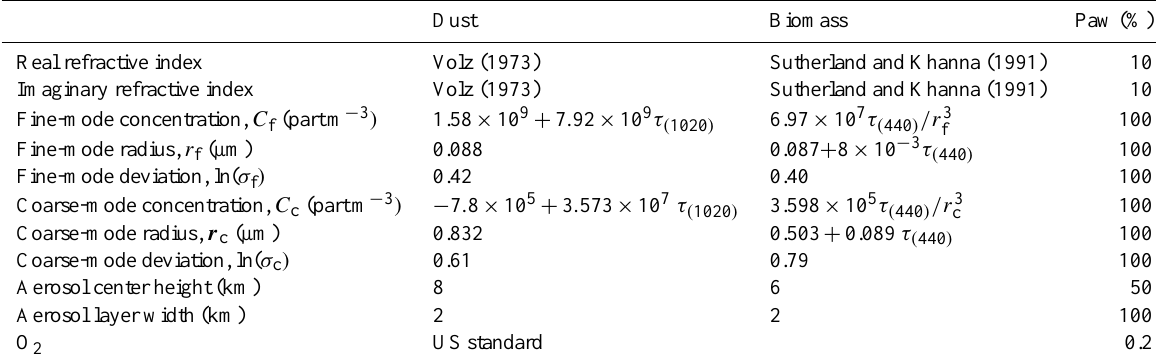
Table 1. Summary of assumed aerosol parameters adapted from Dubovik et al. (2002). C is number of particles in partm − 3 , r mean radius inµm, and σ deviation of the radius inµm. The f and c indices are for fine and coarse mode respectively. τ ( 1020 ) and τ ( 440 ) correspond to the optical depth at 1020 and 440nm,